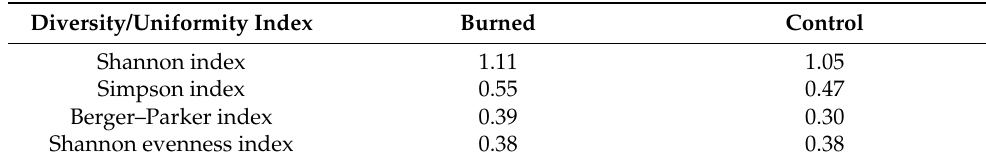
Table 7. Diversity characteristics of the helminth community of the wood mouse in the burned and control areas.